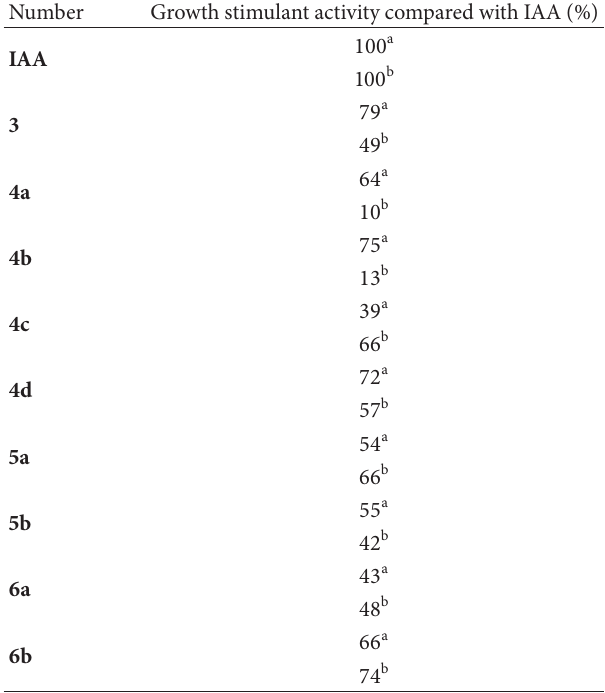
Table 1: Growth stimulant activity of synthesized compounds 3 – 6